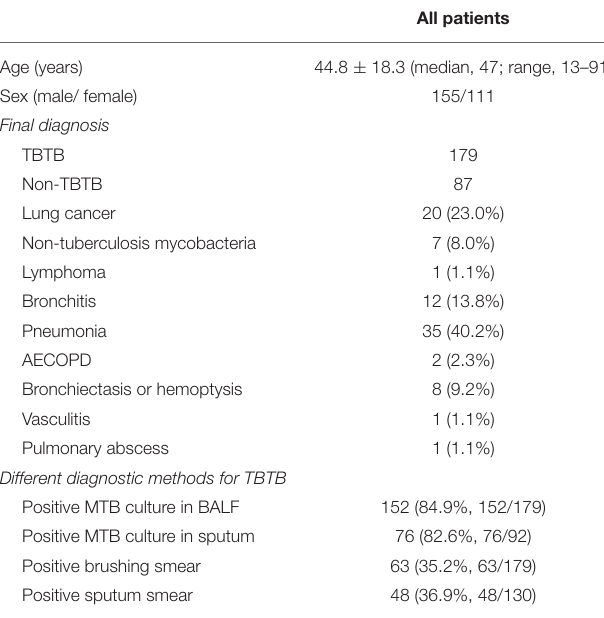
TABLE 1 | Summary of baseline patient characteristics and final diagnosis.